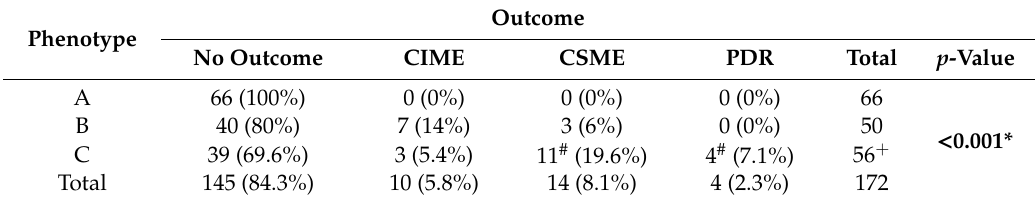
Table 3. Distribution of outcomes across phenotypes. N (% within row).